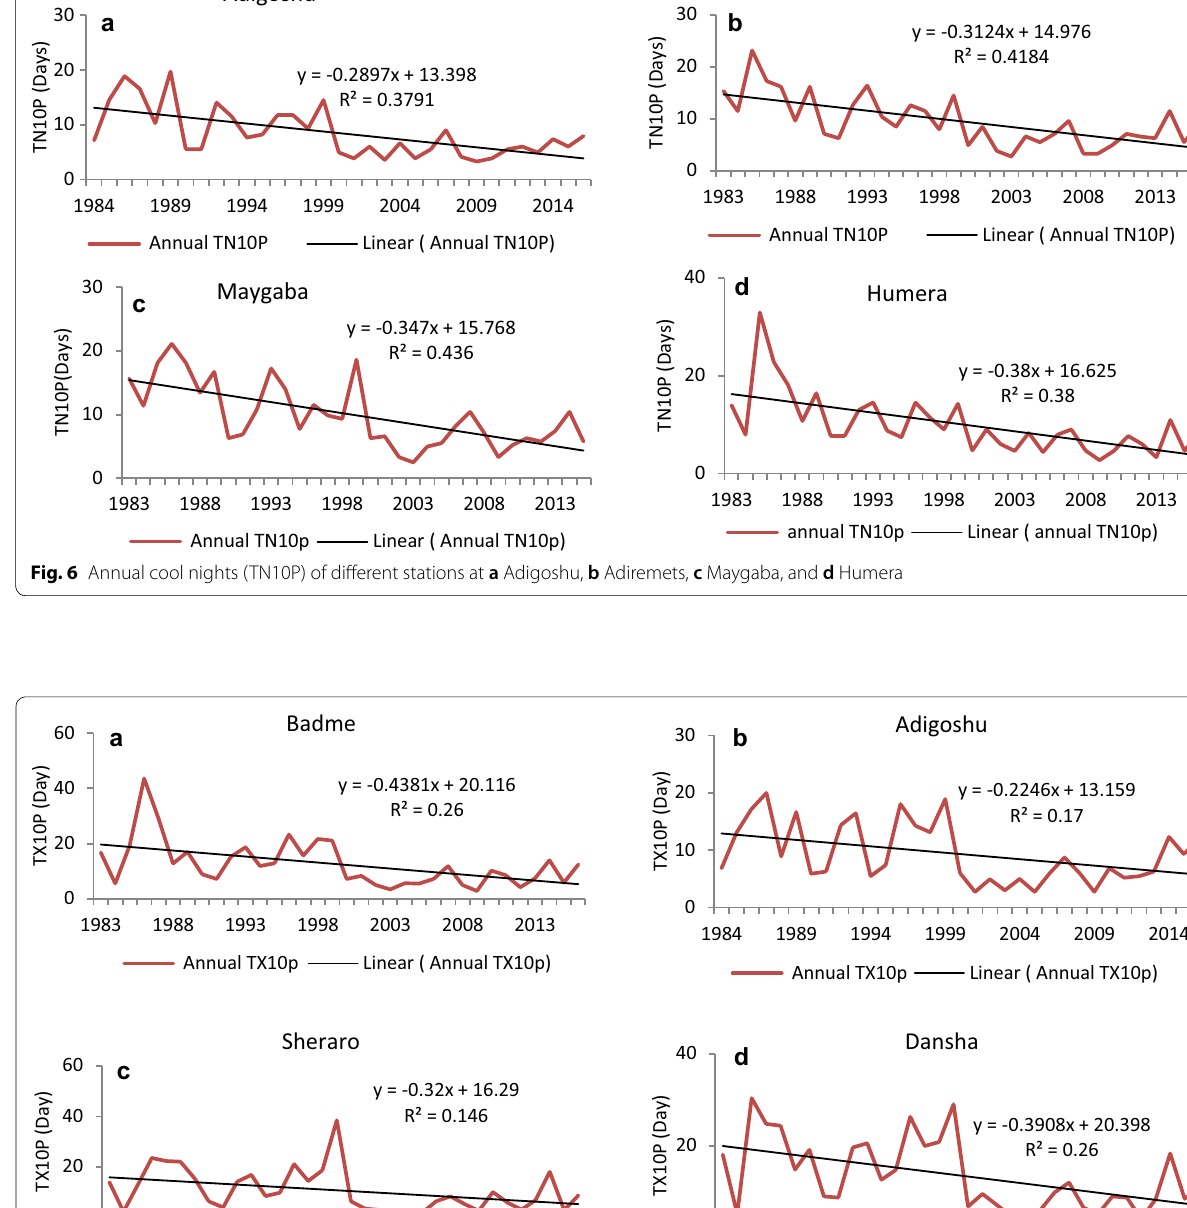
the highest magnitude was observed at Maygaba with 0.68 days (Table 3). The linear regression analysis showed that the coefficient of determination (R 2 ) for warm nights vary between 0.225 and 0.25 (Fig. 8).